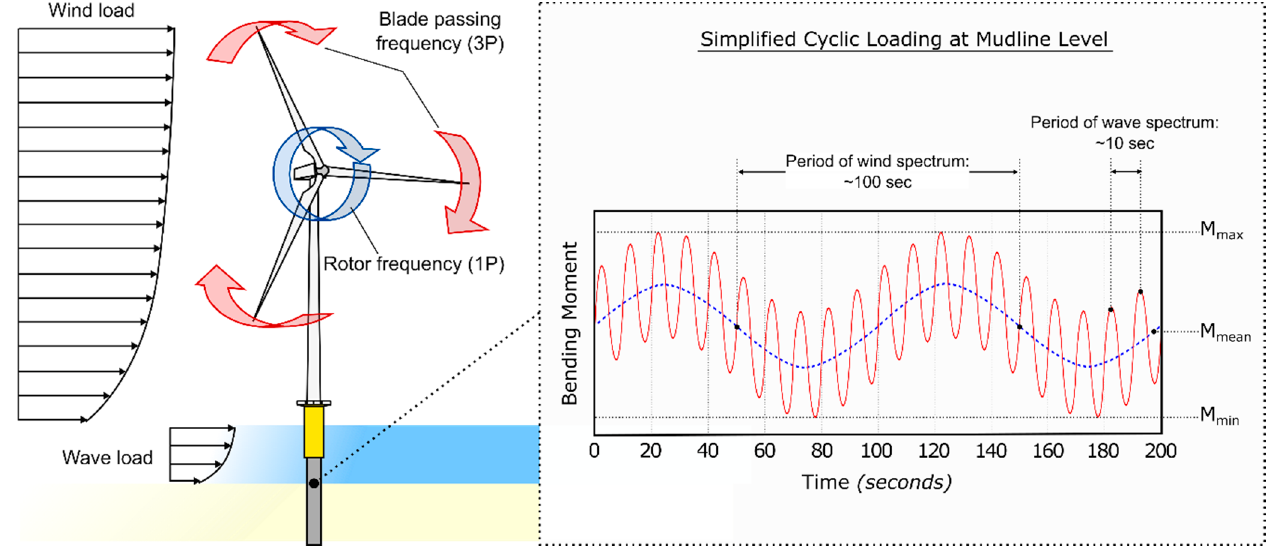
Figure 11. Simplified loading pattern that can be used for scaled model tests.